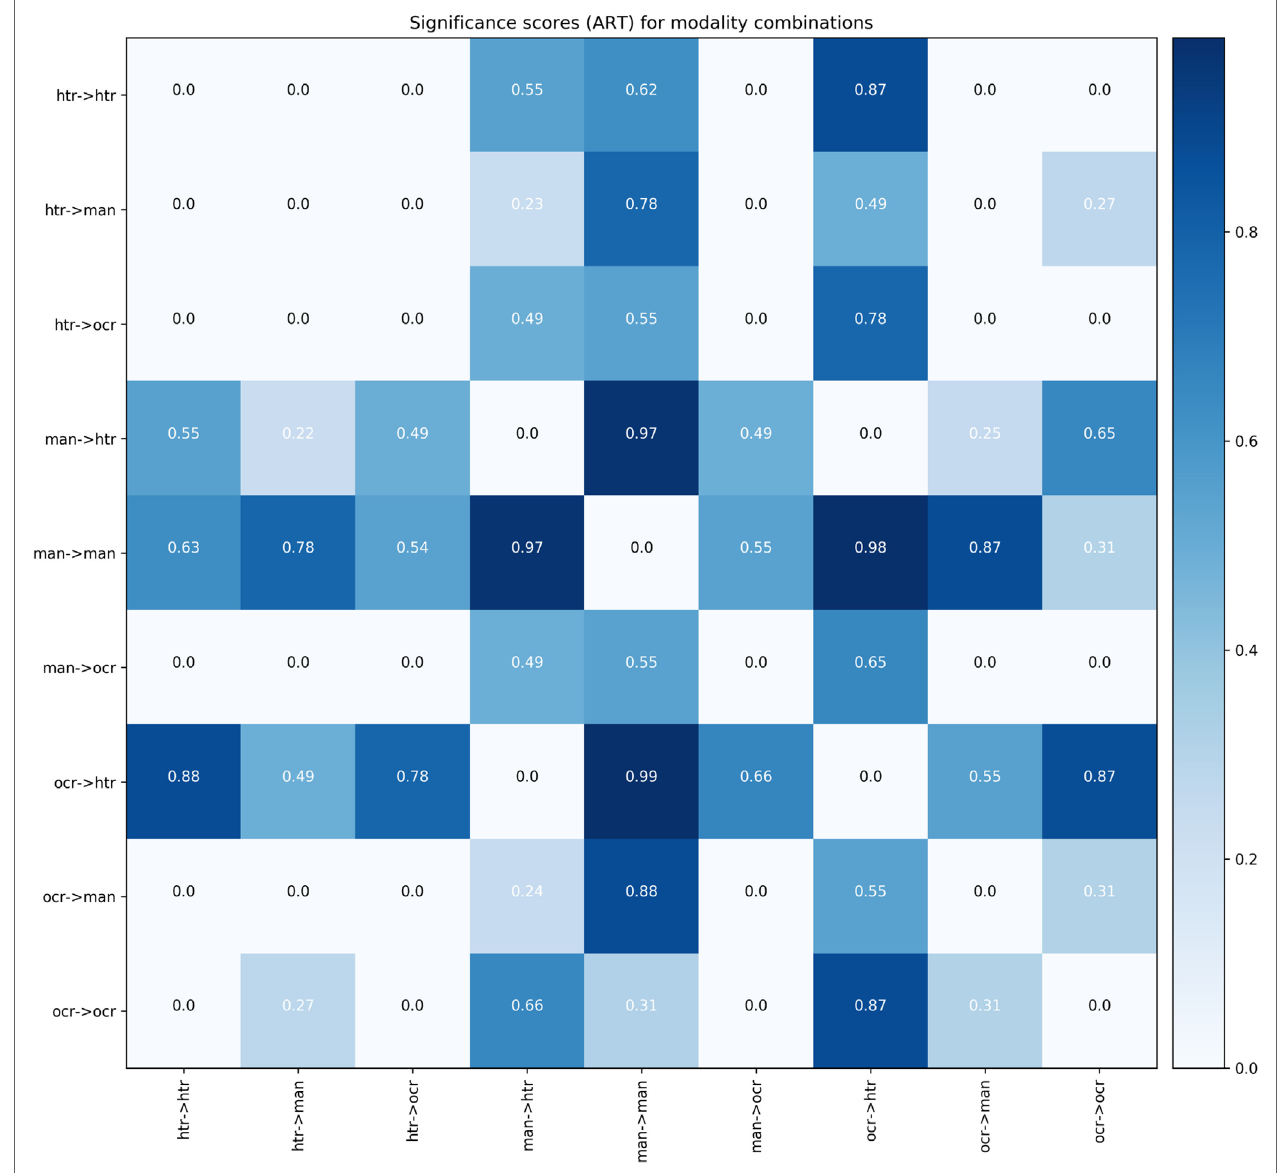
FigUre 11 | Tabular representation of the scores yielded for the outputs of different modality combinations in attribution. Higher scores indicate that two systems produce significantly different